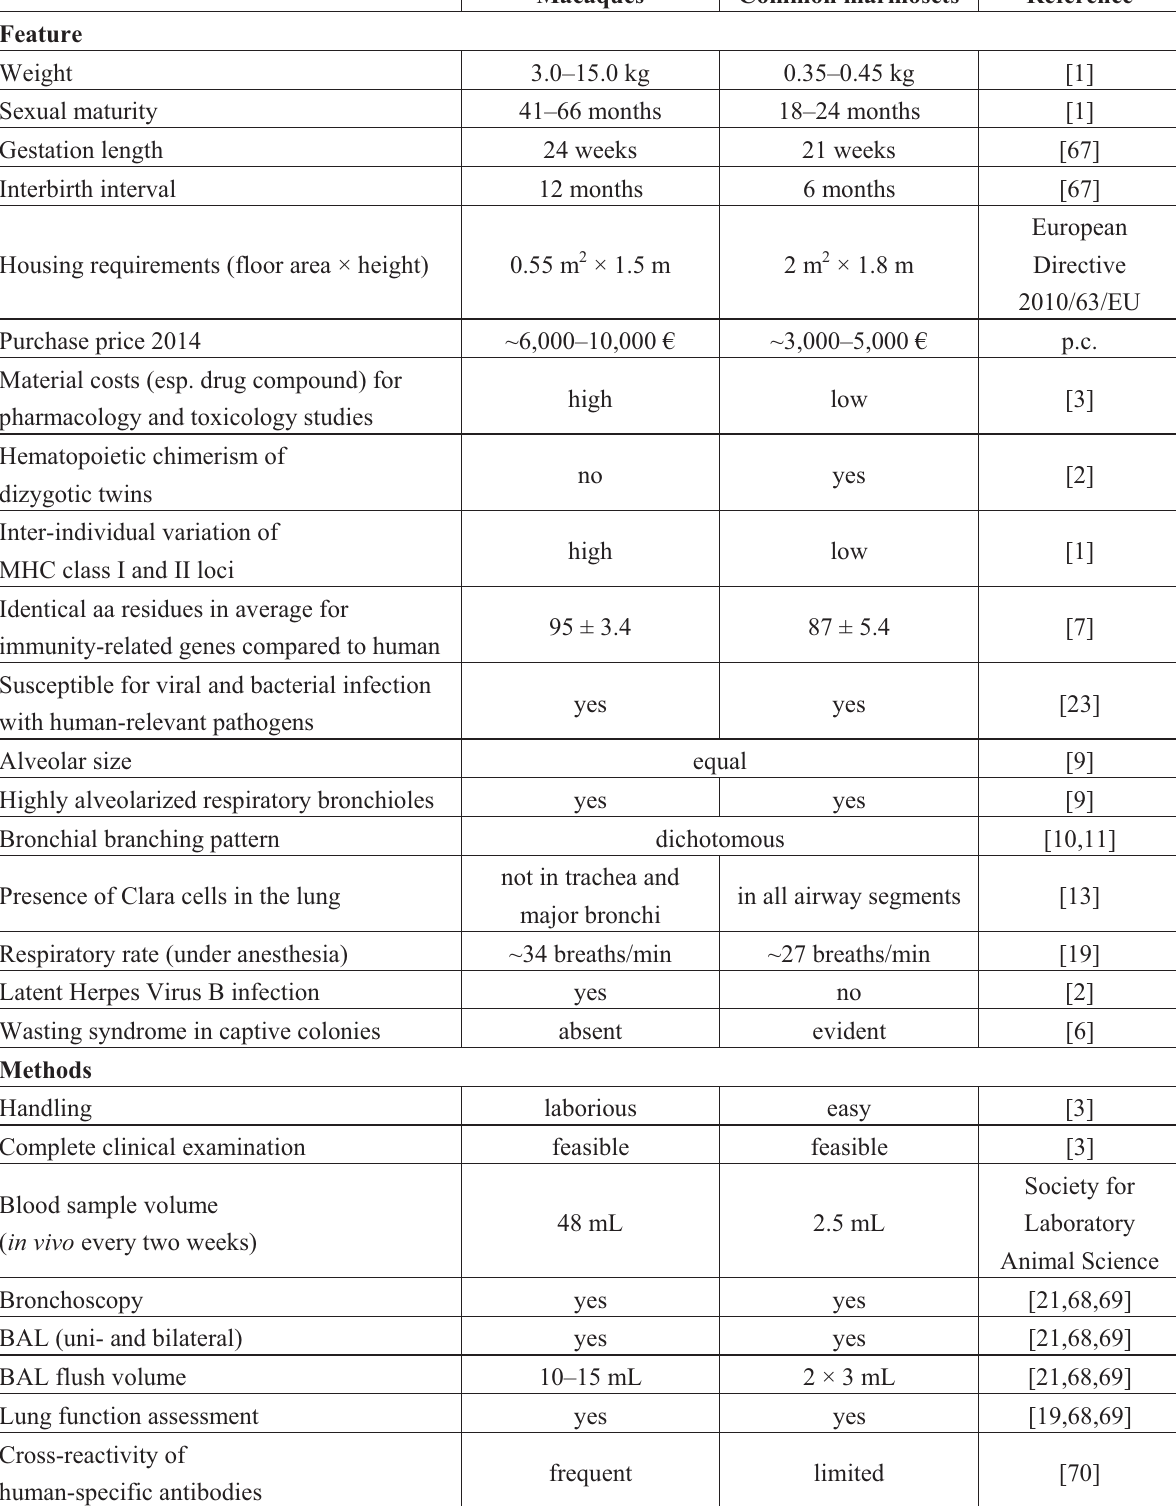
Table 1. Species comparison of advantages and disadvantages of macaque (rhesus, cynomolgus) and common marmoset animal models for respiratory